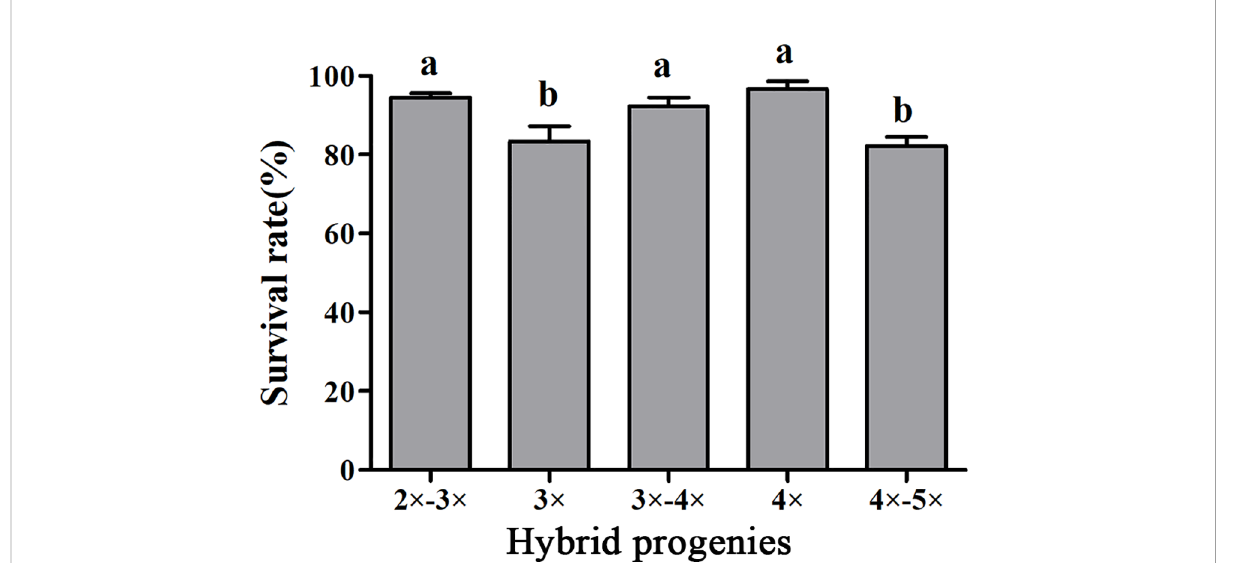
FIGURE 5 Survival rates of hybrid seedlings with different ploidy levels after being transplanted to plastic bags containing a substrate and grown in a shaded greenhouse. Bars represent standard error, and different letters on the top of bars indicate signi fi cant difference in survival rates among hybrid progenies analyzed by Duncan ’ s multiple range test at P < 0.05